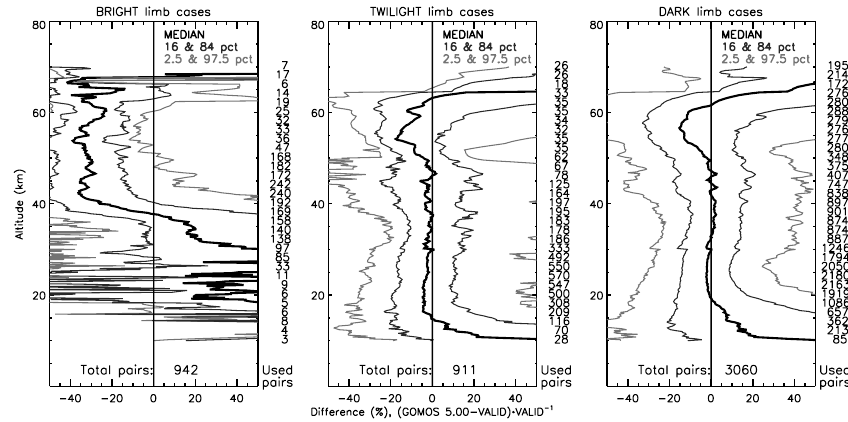
Fig. 4. Validation results for the different limb illumination conditions. Left panel: bright limb; middle panel: twilight limb; right panel: dark limb cases. All plots show the median difference (thick black line) between GOMOS and the validation data together with the 16 and 84 percentiles (thin dark grey lines) and the 2.5 and 97.5 percentiles (thin light grey lines). On the right side of each panel is the number of collocated pairs used for the corresponding altitude.